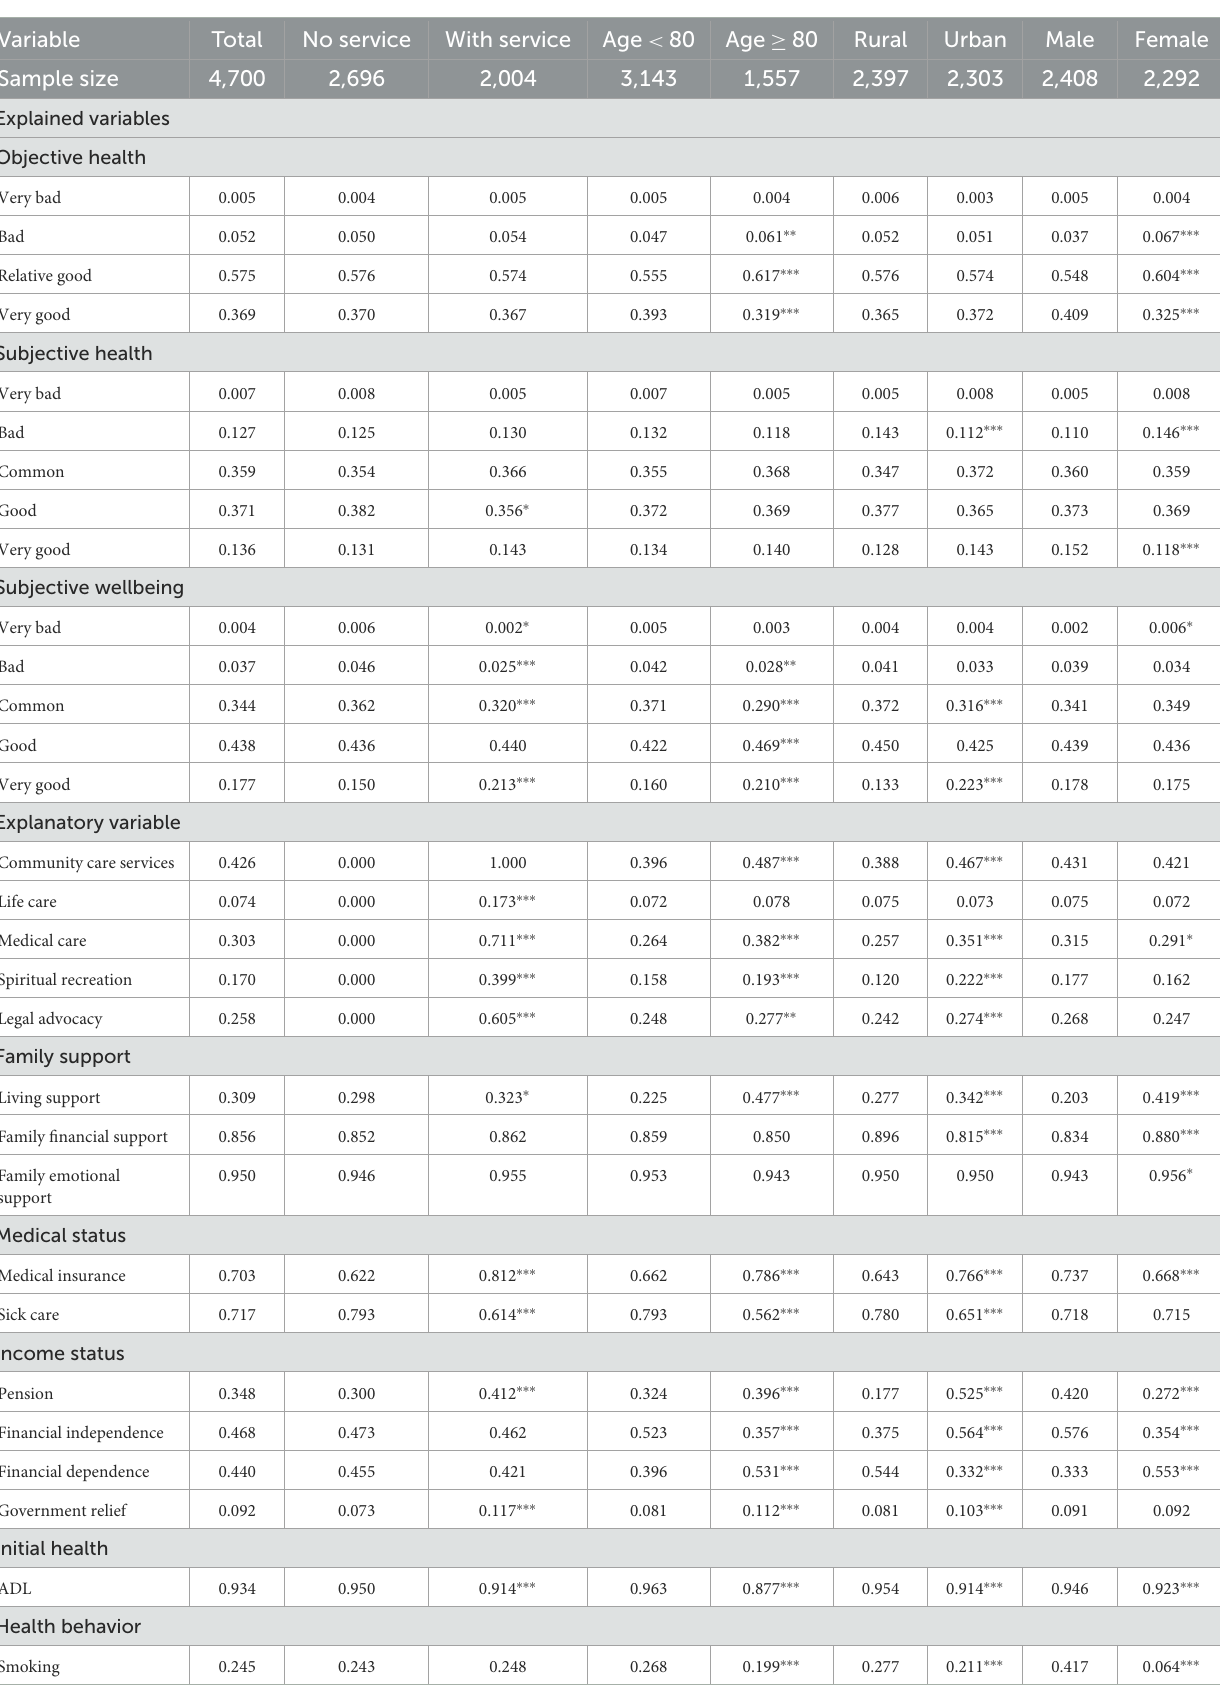
TABLE 1 Summary statistics of main